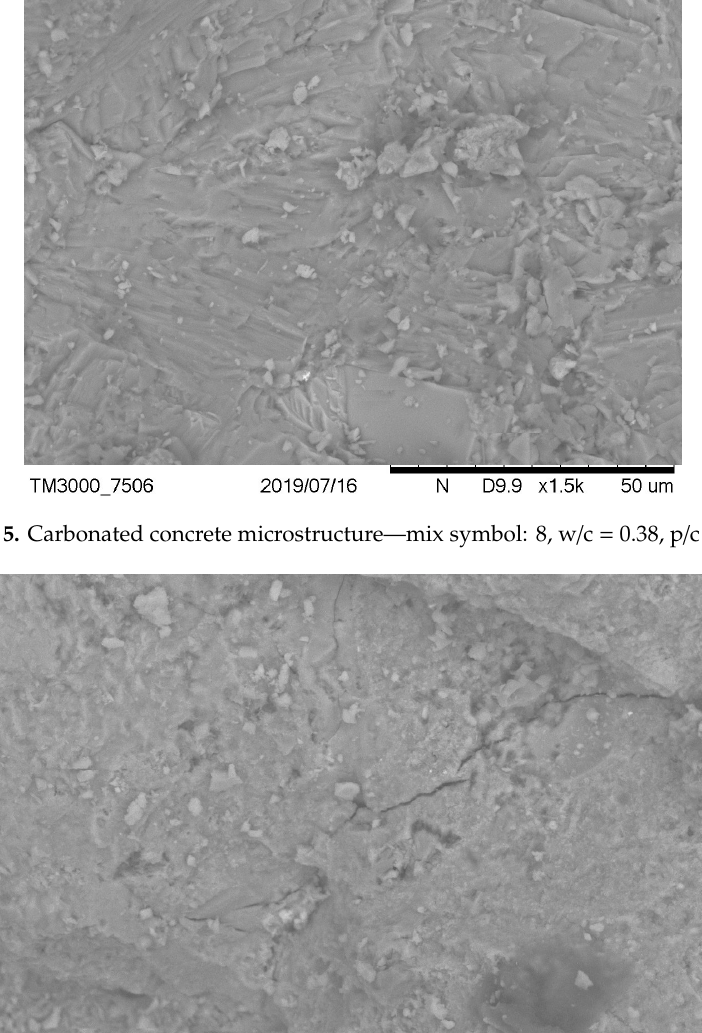
Figure 6. Carbonated concrete microstructure—mix symbol: 2 w/c = 0.52, p/c = 0.46.